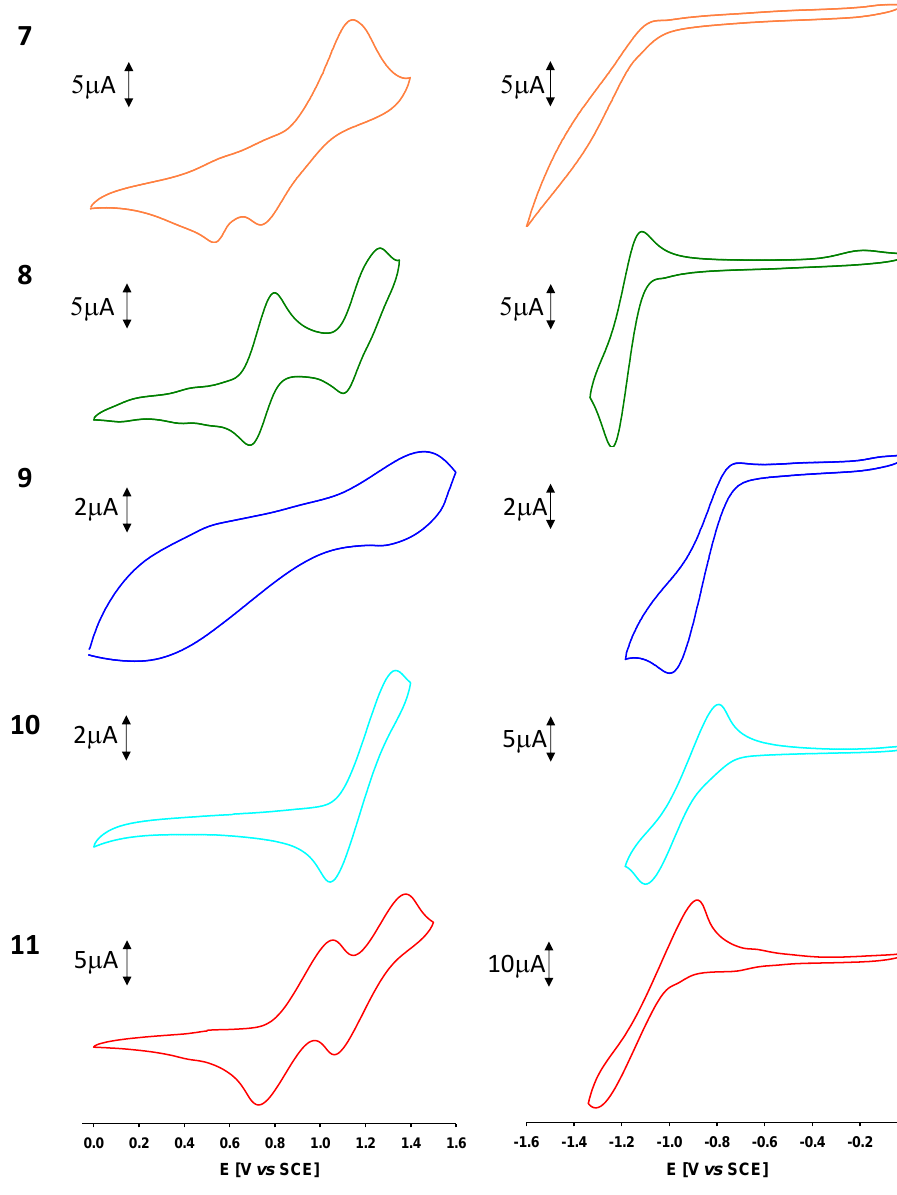
Figure 3. Cyclic voltammograms corresponding to the oxidation (left) and reduction (right) of compounds 7 – 11 recorded in 0.10 M Bu 4 NPF 6 /CHCl 3 , Pt electrodes, scan rate 100 mVs −1 .